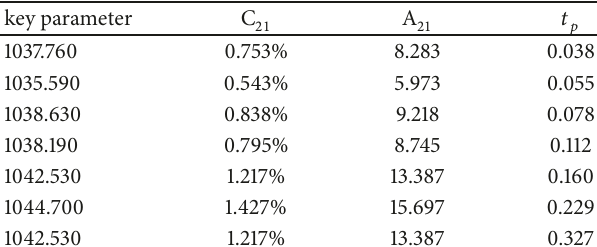
Table 11: Percentage of key parameter over normal threshold, second-level fuzzy comprehensive evaluation, and attenuation fac-